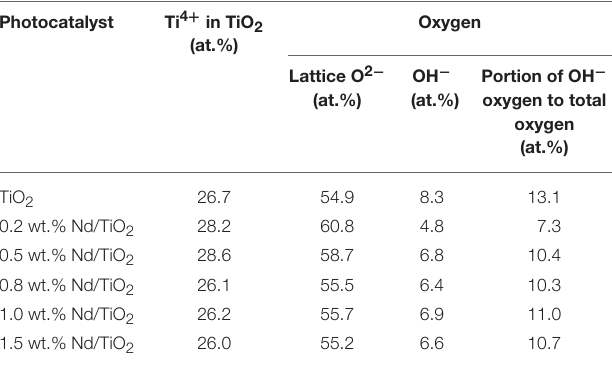
TABLE 3 | Surface composition of Nd-doped TiO 2 photocatalysts determined by XPS. Photocatalyst Ti 4 + in TiO 2